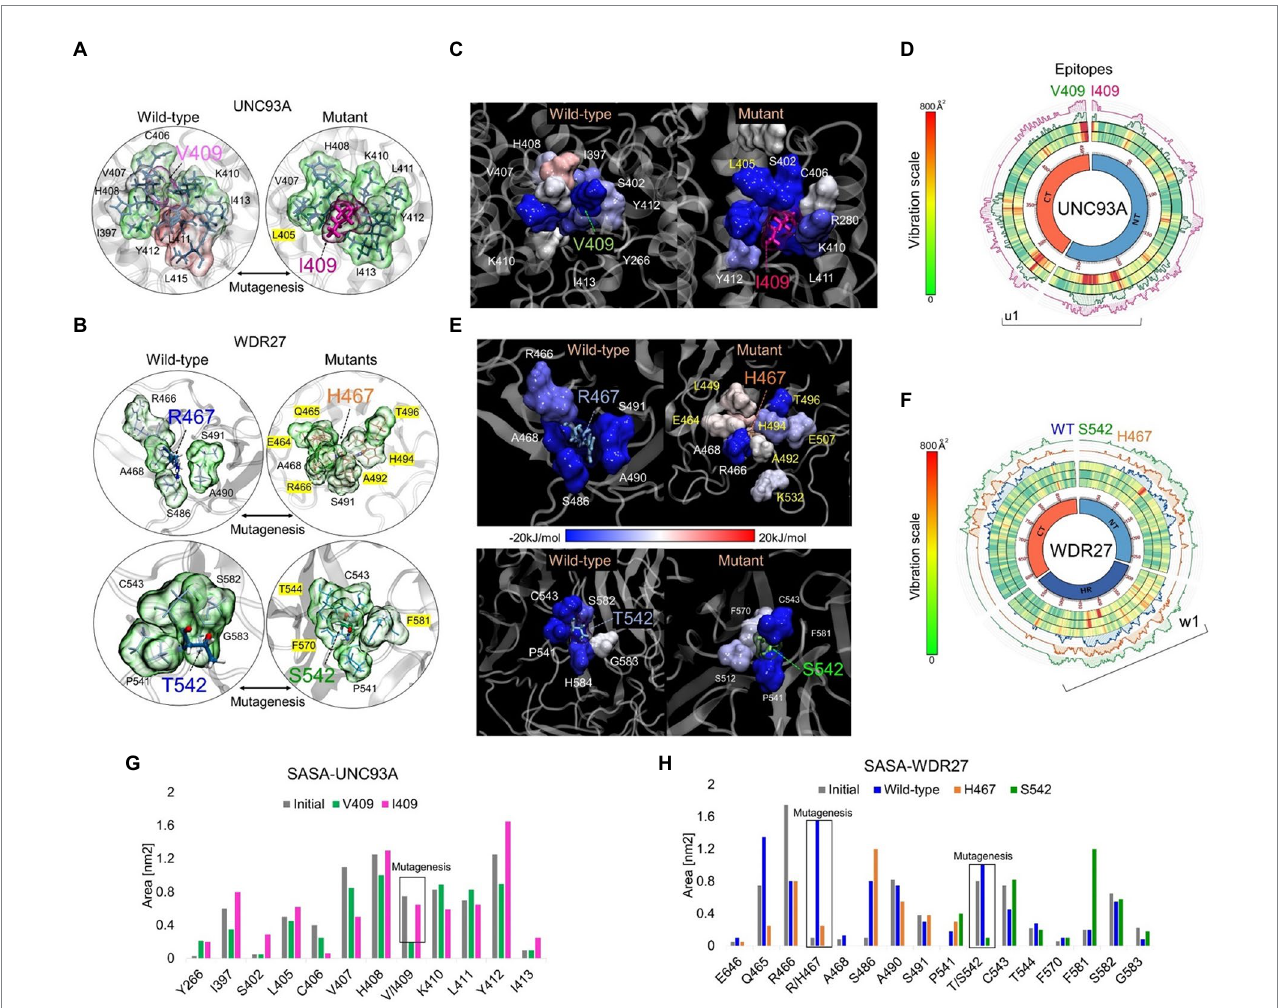
FIGURE 2 In silico analysis of UNC93A and WDR27 amino acid substitutions predict loss of protein function. (A,B) show the UNC93A and WDR27 wild-type and mutant proteins . (C,E) show the MM-PBSA calculation of the main energetic interactions of residues at mutation sites. Blue indicates favorable energies and red unfavorable energies. (D,F) show a Circos plot of the wild-type and mutant full-length protein. The heat map represents the vibrational movement of each residue throughout MD simulations at the scale bar values. The outer histograms show the regions most likely (> 50%) to be epitopes. (G,H) show the solvent-accessible surface area (SASA) average values of the wild-type and mutation residues and their